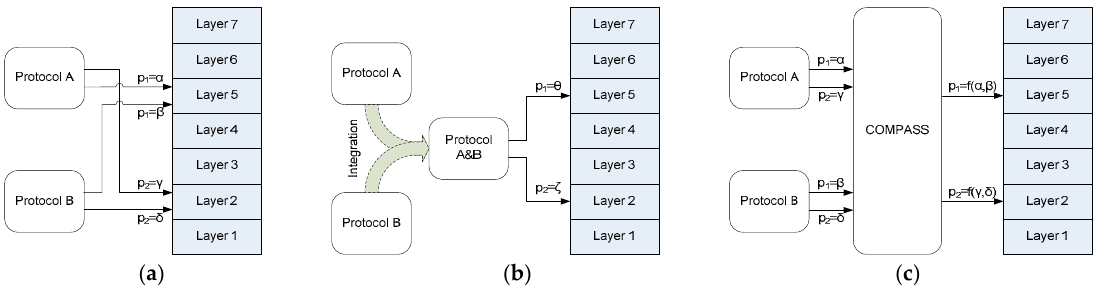
Figure 3. Integration and coordination of protocols operating over the same communication parameters. ( a ) Independent. ( b ) Integration. ( c ) Coordination.